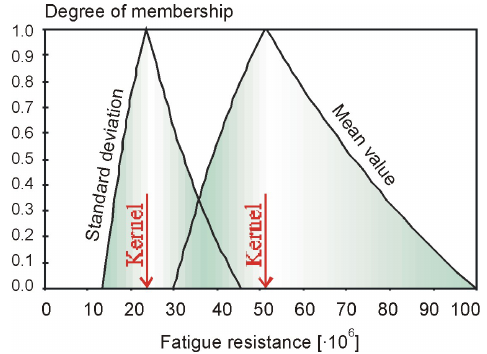
Fig. 10. Fuzzy numbers of mean and standard